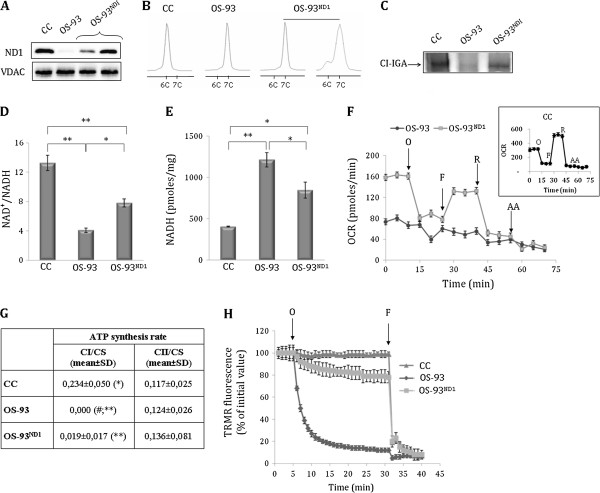
Expression and functional effects of allotopic nND1. (A) Western blot analysis for ND1 in control (CC), OS-93 and OS-93ND1 representative clones. Voltage-dependent anion channel (VDAC) was used as a loading control. One representative experiment of three is shown. (B) m.3571insC mutation load evaluation by fluorescent (F)-PCR. Wild-type and mutant fragments are distinguished based on the length of the homopolymeric stretch, where 7C corresponds to the C insertion. (C) Complex I in-gel activity (CI-IGA) assay in isolated mitochondria. CI-IGA band is indicated with an arrow. One representative experiment of four is shown. (D-E) NAD+/NADH ratio and NADH levels were measured in cell lysates. Data (mean ± SD) are expressed as pmoles of NADH and normalized for protein content (n = 3; *P <0.05; **P <0.01). (F) Oxygen consumption rate (OCR). Measurements were performed upon injection of 1 μM oligomycin (O), 0.1 μM trifluorocarbonylcyanide phenylhydrazone (FCCP) (F), 1 μM rotenone (R) and 1 μM antimycin A (AA). The inset shows the OCR control cell line (CC) profile, analogous to that of OS-93ND1 cells. Data (mean ± standard error of the mean (SEM)) are expressed as pmoles of O2 per minute per 3 × 104 cells (n = 3). (G) Mitochondrial ATP synthesis driven by pyruvate/malate and succinate, CI and CII substrates, respectively. CS, citrate synthase. (n = 4; #undetectable value; **OS-93 vs CC, P <0.01; **OS-93ND1 vs OS-93, P <0.01; *CC vs OS-93ND1, P <0.05). (H) Mitochondrial membrane potential evaluation in CC, OS-93 and OS-93ND1 cells. Arrows indicate the addition of 6 μM oligomycin (O) and 4 μM FCCP (F). Data are mean ± SEM (n = 6). Fluorescence readings following the addition of oligomycin and preceding that of FCCP revealed a statistically significant difference (P <0.05) for all time points between OS-93 and both CC and OS-93ND1 cells.